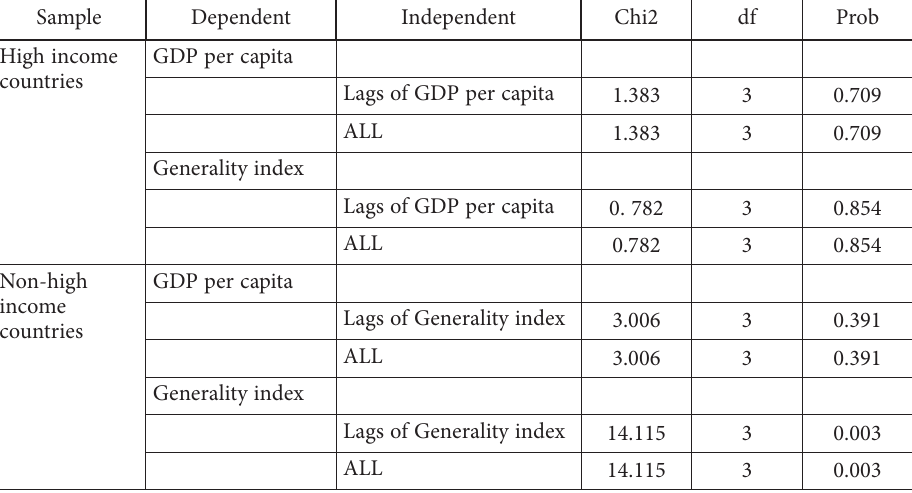
Table C.3. Granger causality test results for GDP per capita and generality index